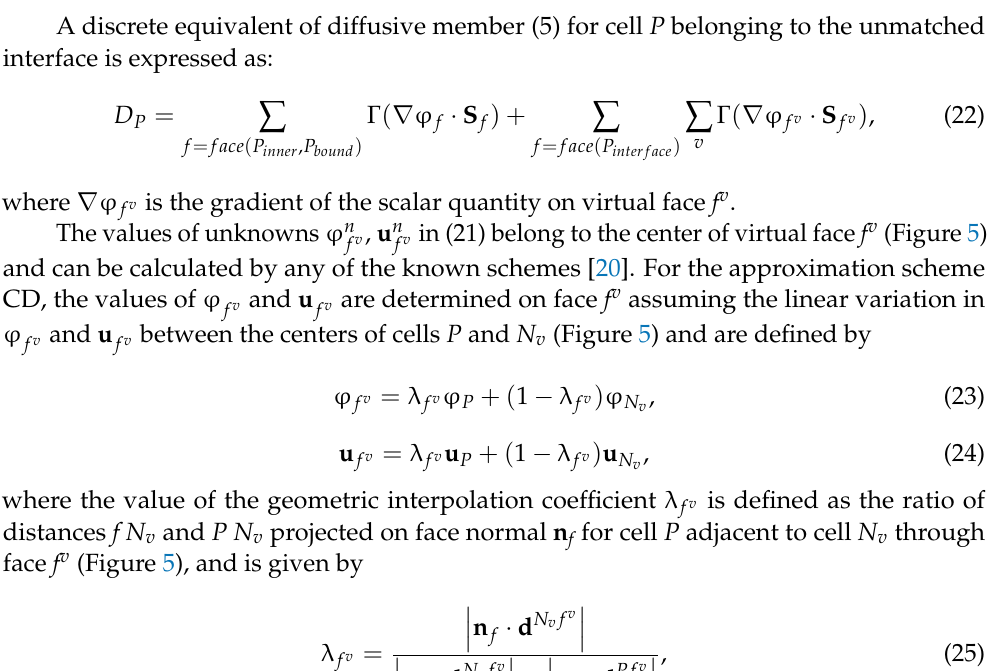
Figure 5. Schematic example of a grid with unmatched inner interfaces.